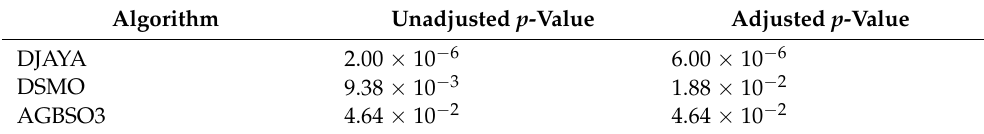
Table 13. P-values by Holm post hoc test (Version 6 is the control method). Algorithm